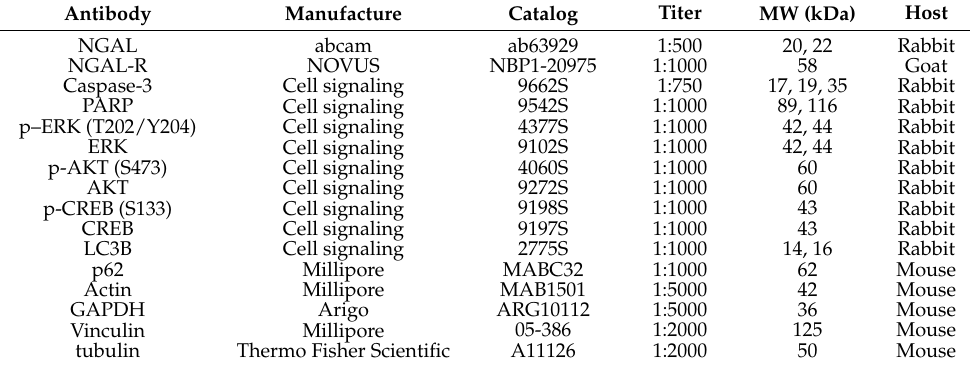
Table 2. Primary antibodies used in western blot (WB).